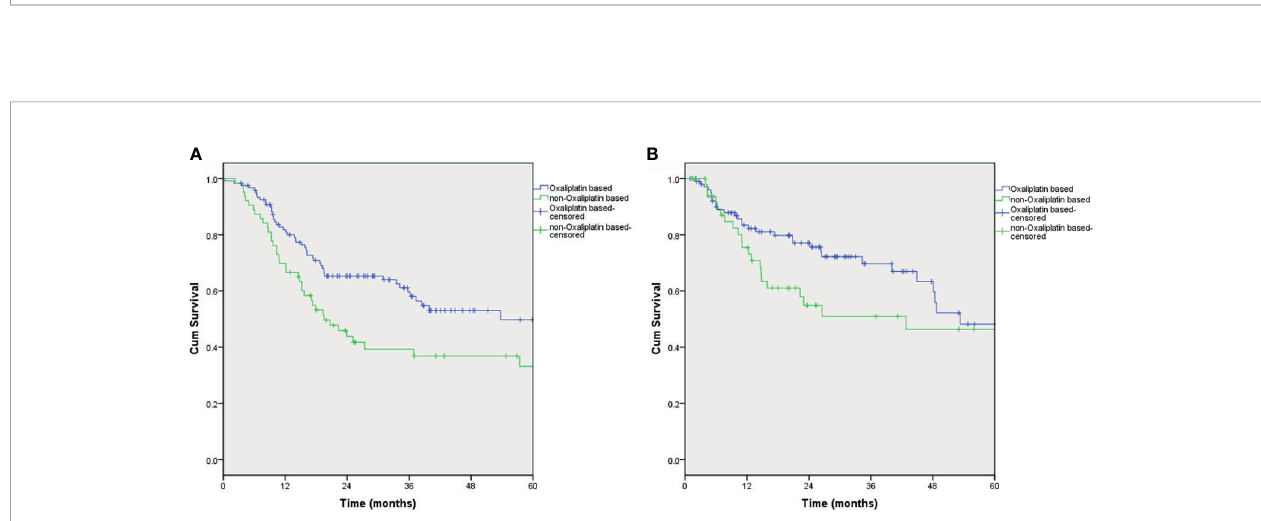
FIGURE 2 | Overall survival and recurrence-free survival of patients who received the oxaliplatin-based regimen. (A) Overall survival, P=0.01; (B) Recurrence-free survival, P=0.178.